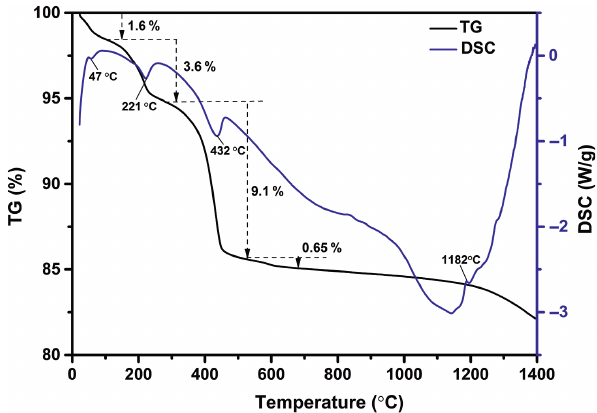
Figure 1: TG/DSC diagrams of the mixture without